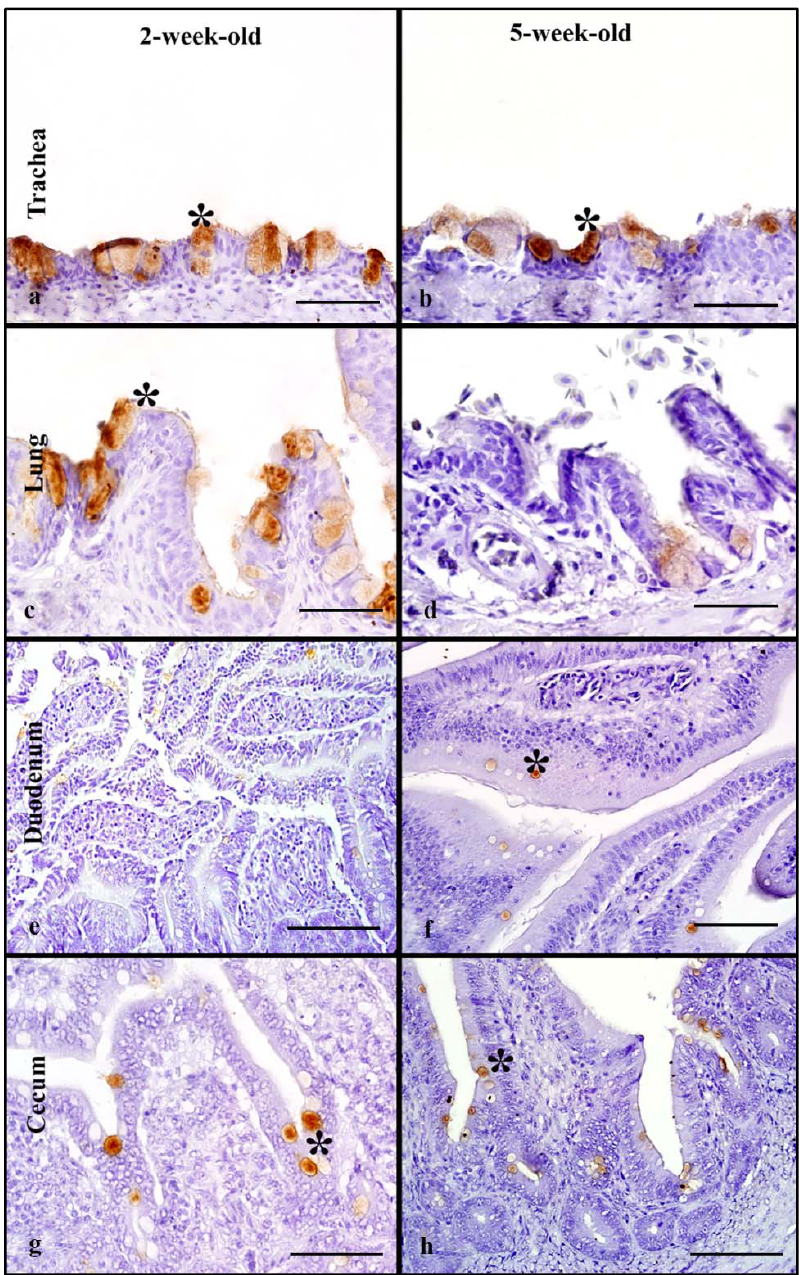
Figure 6. Surface area of LPAIV H5 rHA binding in Mallard ducks of different age groups, denoted by dark brown staining using 3,3-diaminobenzimidine (DAB) HRP via protein histochemistry, denoted by asterisk (*). Note mild to moderate rHA binding in the trachea and lung of 2-week-old and 5-week-olds mallards ( a – d ). In the cecum, similar mild rHA bindings is evident in 2- and 5-week-old birds ( e ). Scale bar is 50 µm.